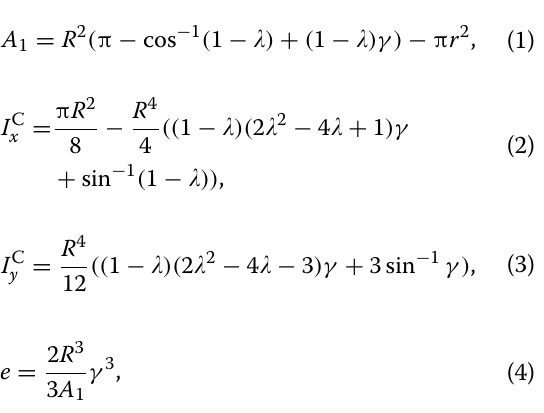
Figure 3 The curve of I C x and I C y with respect to (cid:31) ( R